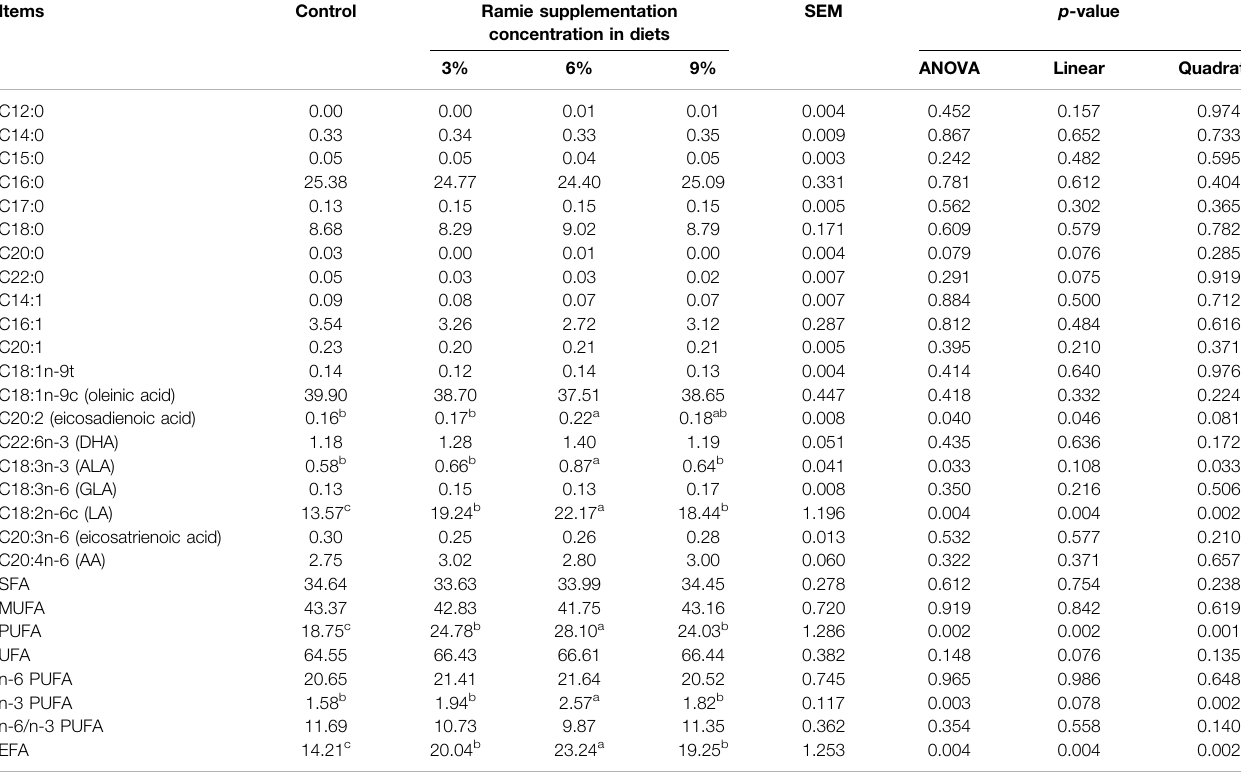
TABLE 6 | Effects of dietary ramie supplementation on fatty acid composition in egg yolk (g/100 g FA). Items Control Ramie supplementation